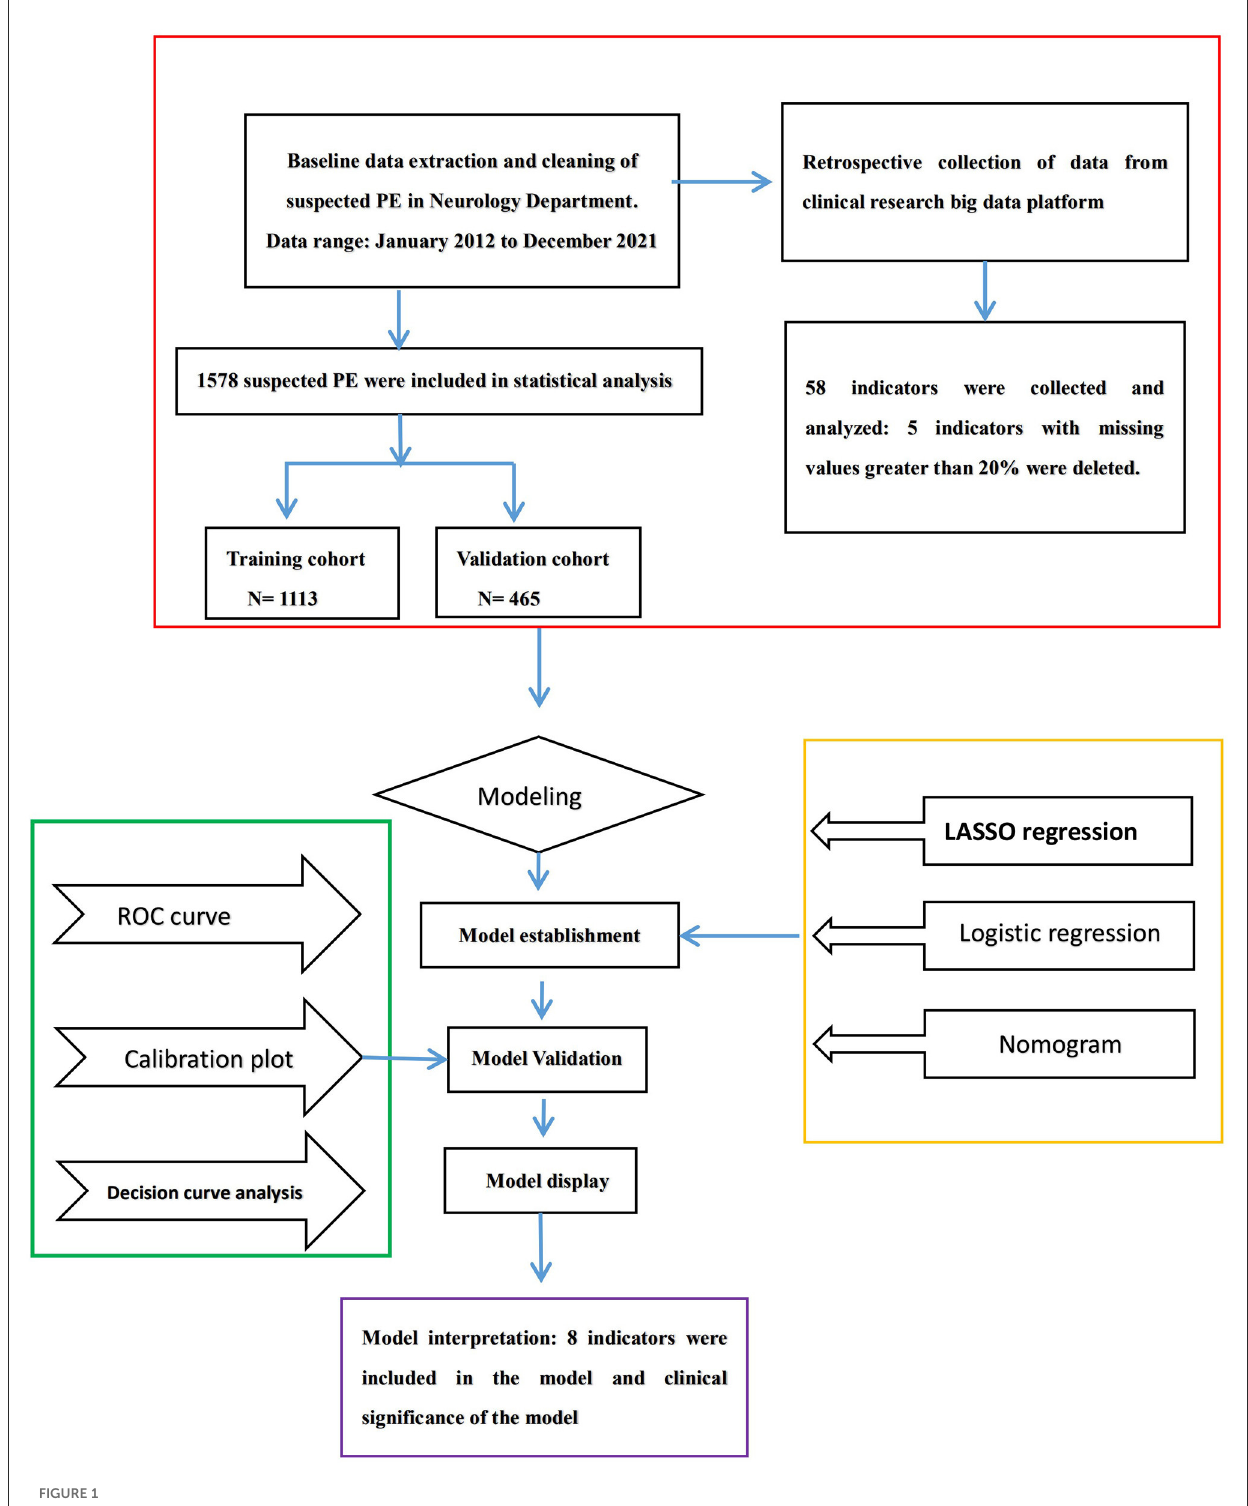
FIGURE1 Flowchart of the processing step for predicting PE.